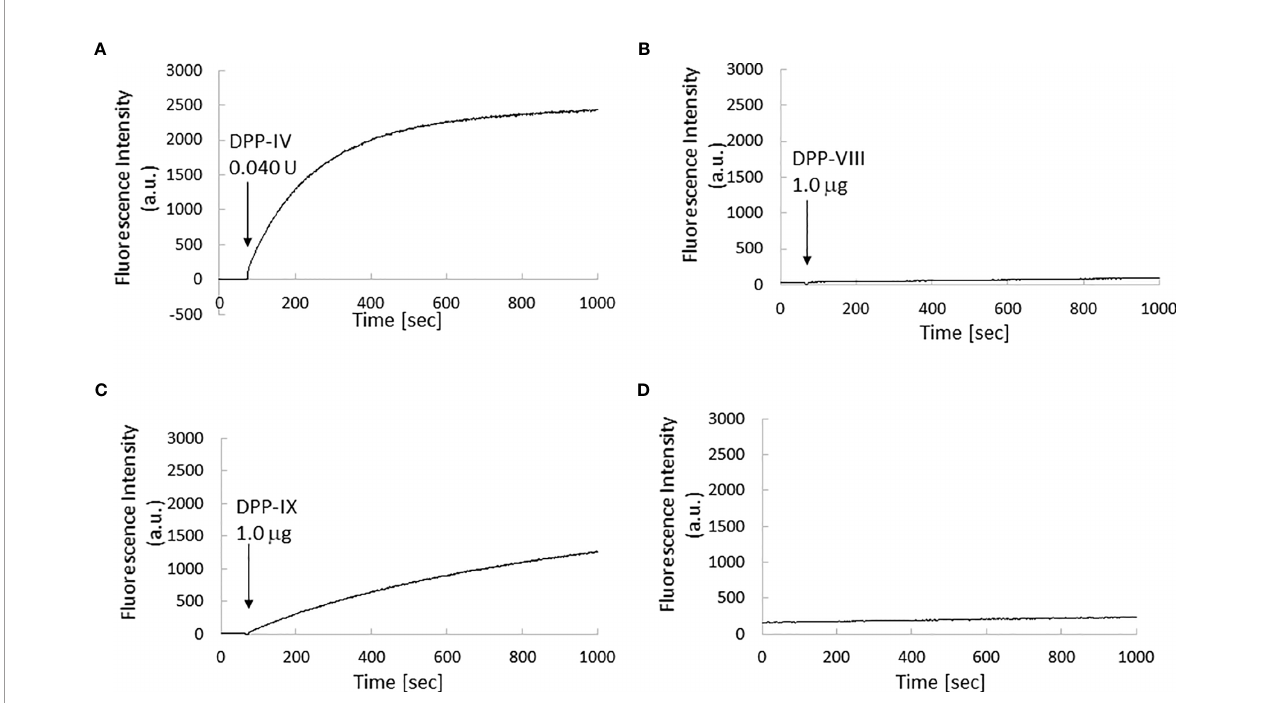
FIGURE 5 | Kinetics of fl uorescence intensity of GP-HMRG upon enzyme addition. µ Excitation/emission wavelengths were 495 nm/525 nm. Trends of fl uorescence intensities after adding DPP-IV (0.040 units, 0.013 units/ml; (A) , DPP-VIII (1.0 µg, 0.033 µg/ml; (B) , or DPP-IX (1.0 µg, 0.033 µg/ml; (C) to GP-HMRG. Increase of fl uorescence intensity of GP-HMRG with no addition of enzymes was also demonstrated in panel (D) .